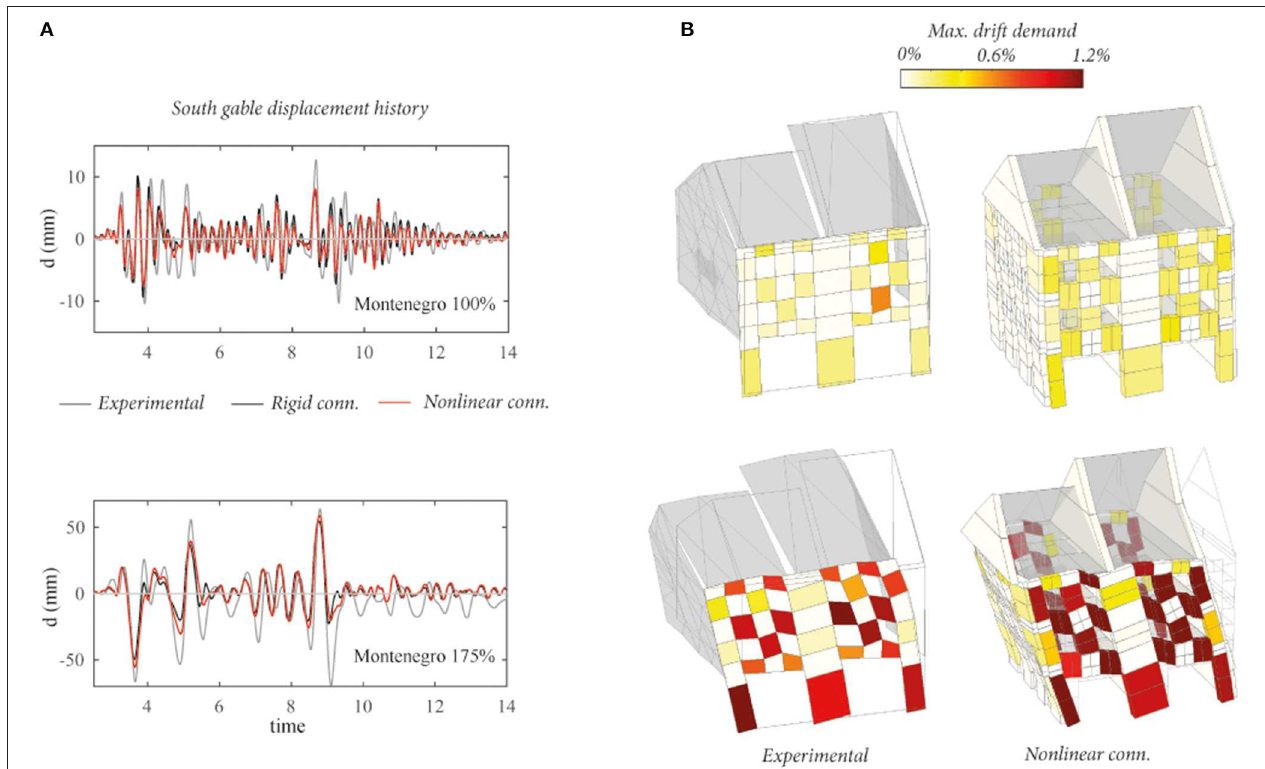
FIGURE 8 | Stone masonry building: (A) time-history displacement d of the South gable; (B) comparison between maximum total experimental and numerical element